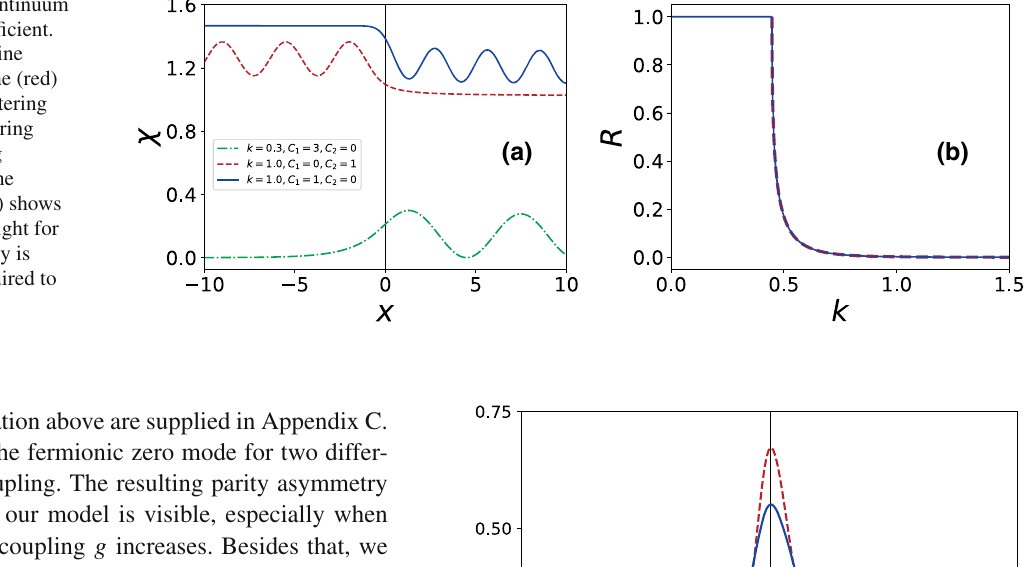
Fig. 5 a Boson field continuum states. b Reflection coefficient. In both cases, the solid line (blue) and the dashed line (red) show the graphs for scattering from the right and scattering from the left considering g = 0 . 1, respectively. The dot-dashed curve (green) shows the scattering from the right for the case where the energy is below the threshold required to surpass the barrier